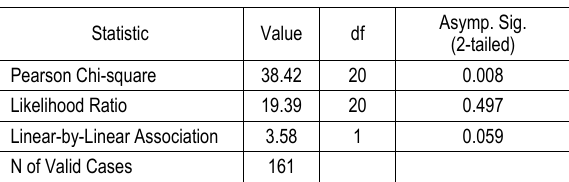
Table 15. Perception of risk versus economic